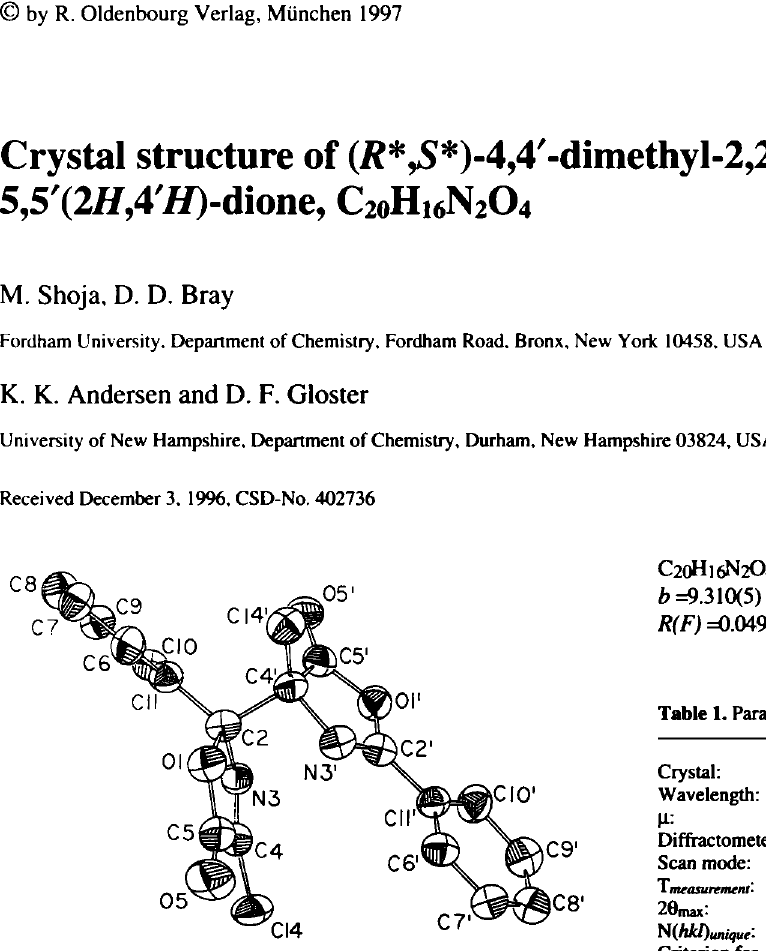
Table 1. Parameters used for the X-ray data collection Crystal: